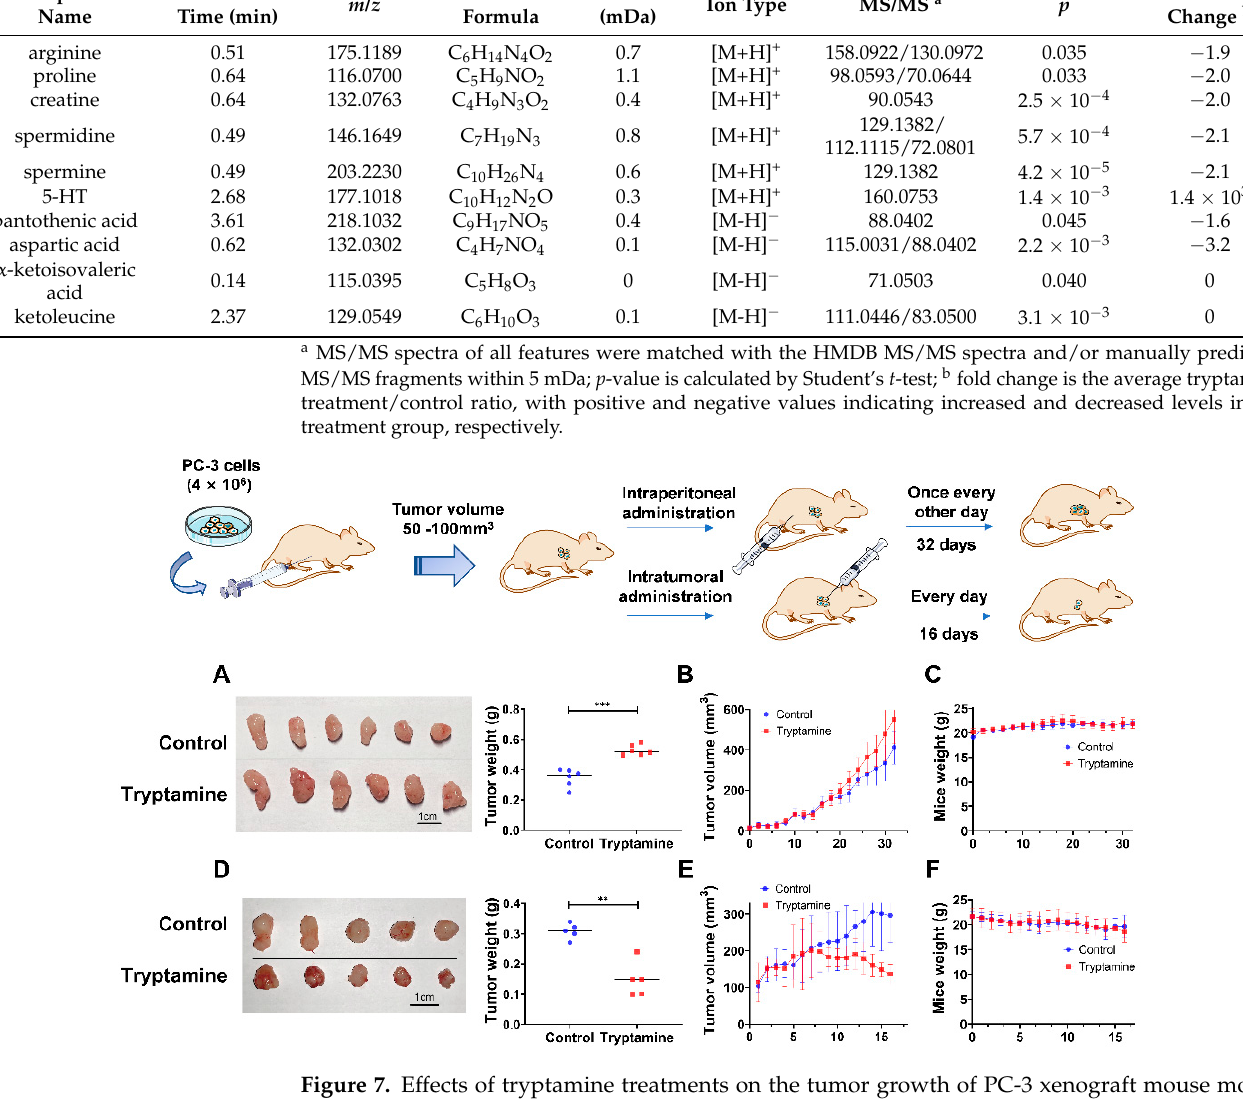
Figure 7. Effects of tryptamine treatments on the tumor growth of PC-3 xenograft mouse model. ( A , D ) Size and weight of the tumors, ( B , E ) growth curves of tumors, and ( C , F ) body weights of PC-3 xenograft mice that received intraperitoneal administration of tryptamine (80 mg/kg, n = 6) and intratumoral administration of tryptamine (1 mg/100 mm 3 , n = 5), respectively. Data are represented as mean ± SD, ** p < 0.01, *** p < 0.001. Table 3. Tentative identification of differential metabolites of PC-3 cells between control and tryp- tamine treatment groups.